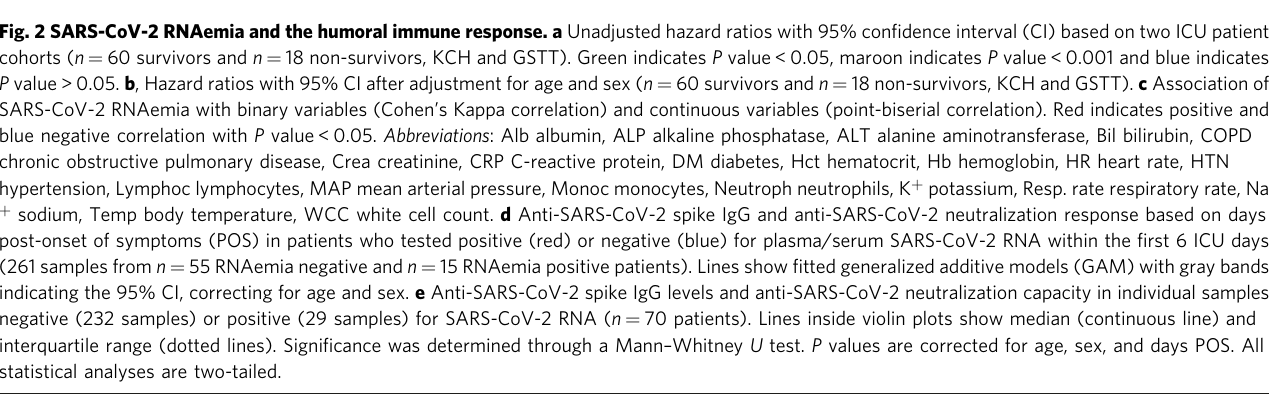
Fig. 2 SARS-CoV-2 RNAemia and the humoral immune response. a Unadjusted hazard ratios with 95% con fi dence interval (CI) based on two ICU patient cohorts ( n = 60 survivors and n = 18 non-survivors, KCH and GSTT). Green indicates P value < 0.05, maroon indicates P value < 0.001 and blue indicates P value > 0.05. b , Hazard ratios with 95% CI after adjustment for age and sex ( n = 60 survivors and n = 18 non-survivors, KCH and GSTT). c Association of SARS-CoV-2 RNAemia with binary variables (Cohen ’ s Kappa correlation) and continuous variables (point-biserial correlation). Red indicates positive and blue negative correlation with P value < 0.05. Abbreviations : Alb albumin, ALP alkaline phosphatase, ALT alanine aminotransferase, Bil bilirubin, COPD chronic obstructive pulmonary disease, Crea creatinine, CRP C-reactive protein, DM diabetes, Hct hematocrit, Hb hemoglobin, HR heart rate, HTN hypertension, Lymphoc lymphocytes, MAP mean arterial pressure, Monoc monocytes, Neutroph neutrophils, K + potassium, Resp. rate respiratory rate, Na + sodium, Temp body temperature, WCC white cell count. d Anti-SARS-CoV-2 spike IgG and anti-SARS-CoV-2 neutralization response based on days post-onset of symptoms (POS) in patients who tested positive (red) or negative (blue) for plasma/serum SARS-CoV-2 RNA within the fi rst 6 ICU days (261 samples from n = 55 RNAemia negative and n = 15 RNAemia positive patients). Lines show fi tted generalized additive models (GAM) with gray bands indicating the 95% CI, correcting for age and sex. e Anti-SARS-CoV-2 spike IgG levels and anti-SARS-CoV-2 neutralization capacity in individual samples negative (232 samples) or positive (29 samples) for SARS-CoV-2 RNA ( n = 70 patients). Lines inside violin plots show median (continuous line) and interquartile range (dotted lines). Signi fi cance was determined through a Mann – Whitney U test. P values are corrected for age, sex, and days POS.